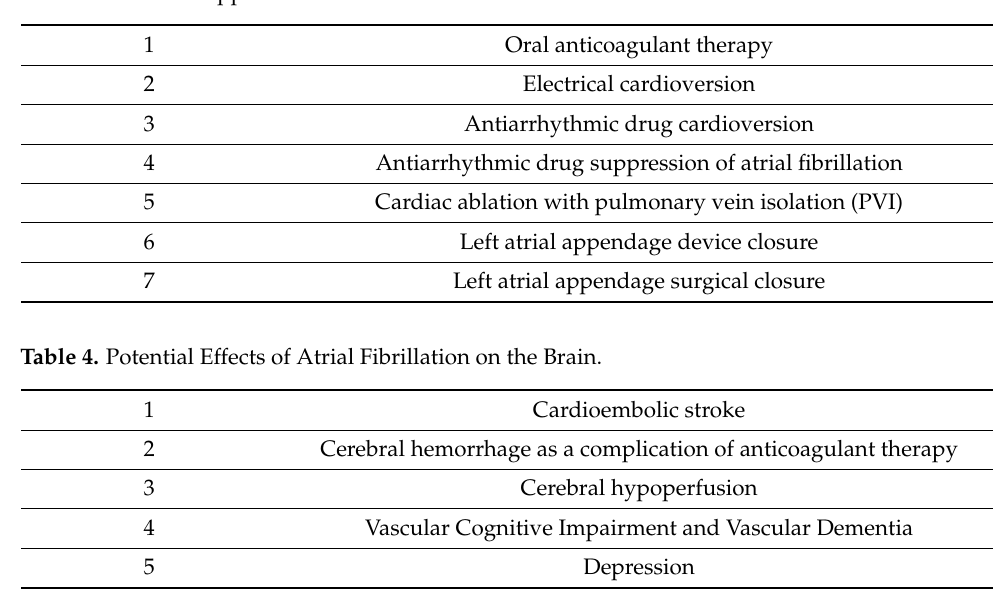
Table 3. Potential Approaches to Stroke Prevention in Atrial Fibrillation.